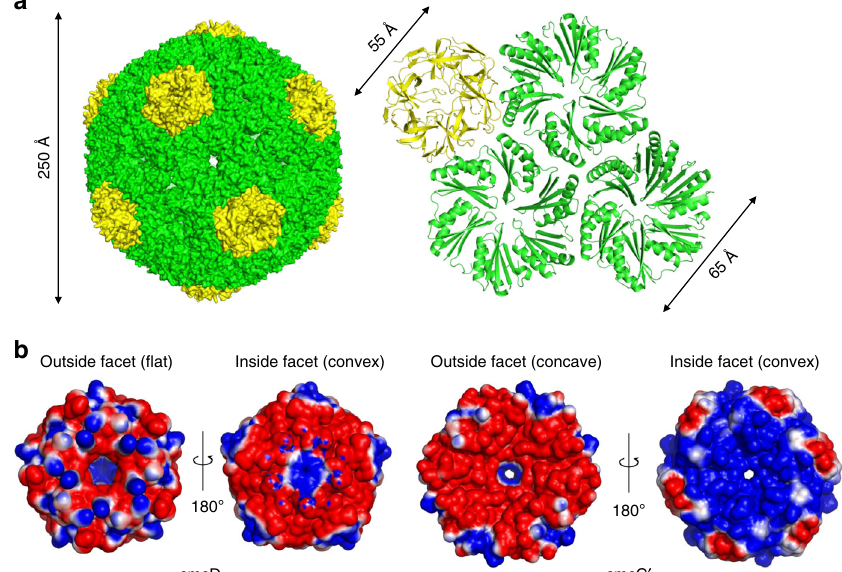
Fig. 4 Cryo-EM structure of pT = 4 quasi-icosahedral BDP and its penatameric and hexameric components. a Surface model of pT = 4 quasi-icosahedral BDP particle, displayed on the left side. A ribbon model of a cmcD pentamer and three cmcC ′ hexamers is displayed on the right side. Pentameric cmcD protein is colored in yellow and hexameric cmcC ′ is colored in green. Note that the fi vefold symmetry axis is located at the center of cmcD pentamer and threefold axis is located in the middle between three cmcC ′ hexamers. b Electrostatic surface potential of pentameric cmcD and hexameric cmcC ′ . Note the pores in the centers of pentamers and hexamers. The surface contour levels were set to − 1 kT / e (red) and + 1 kT / e